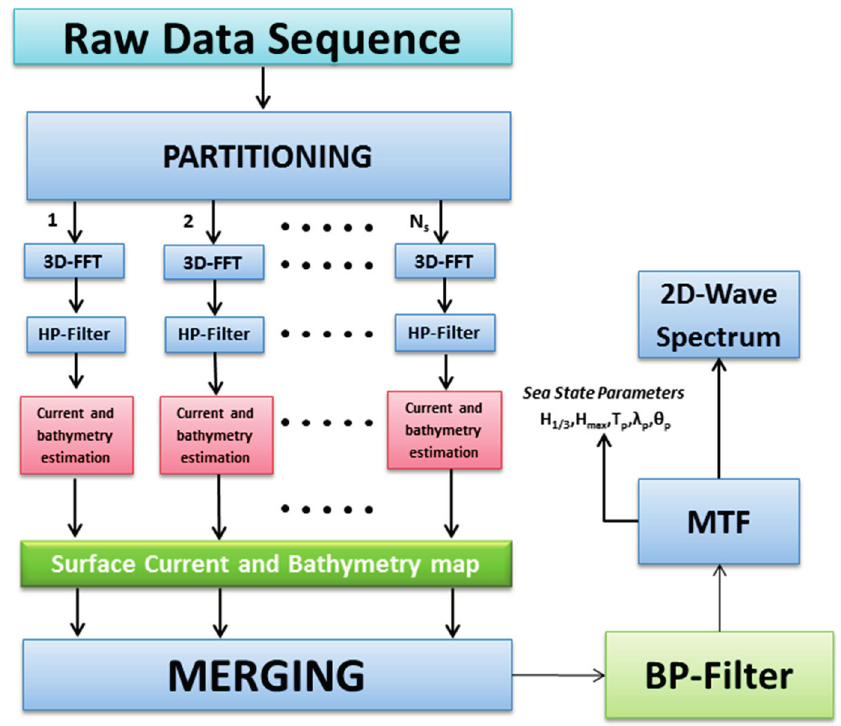
Figure 1. Block diagram of the reconstruction